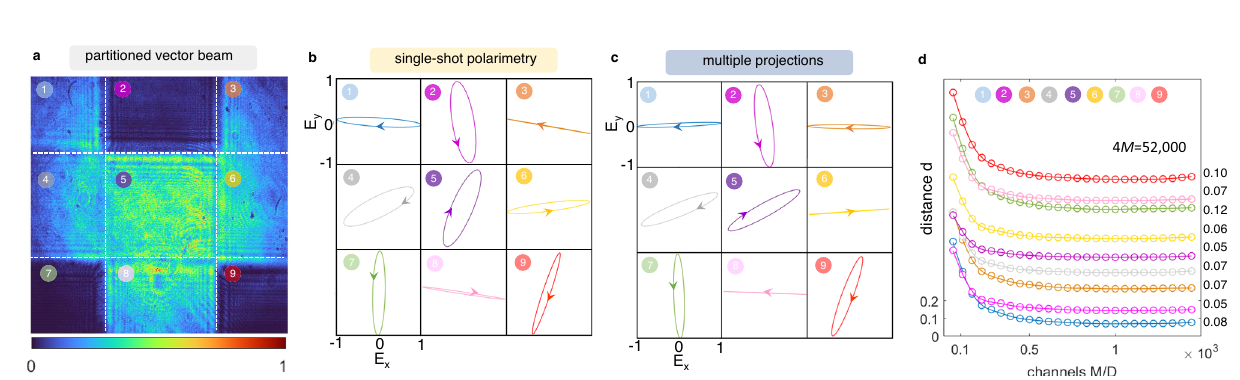
Fig. 5 | Single-shot polarimetry of nine-parted vector beams. a Intensity p V measuredwhenverticallyprojectingageneratedbeamwith D =9.Thetotalstate ∣ s i belongs to a 27-dimensional phase space. b Single-shot measurement of the nine